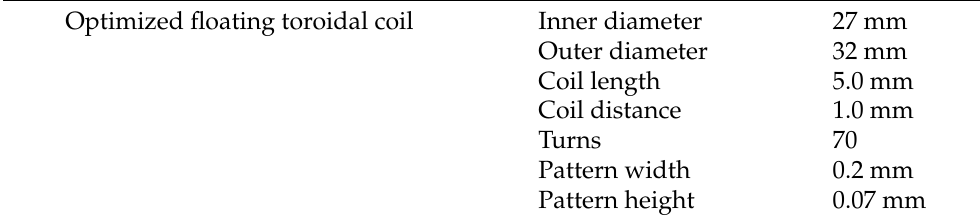
Table 3. Dimensions of the optimized floating toroidal coil.